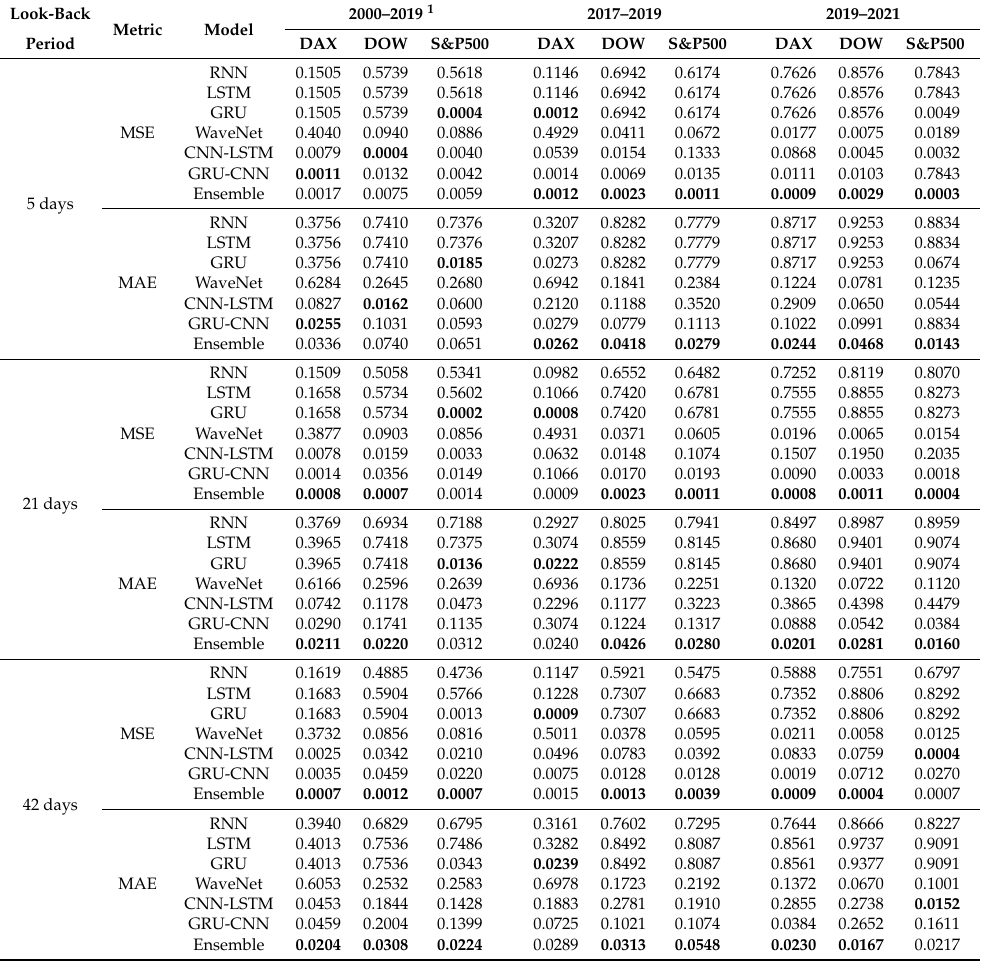
Table 3. Comparison of one-time-step prediction between proposed and benchmark models. Look-Back Metric